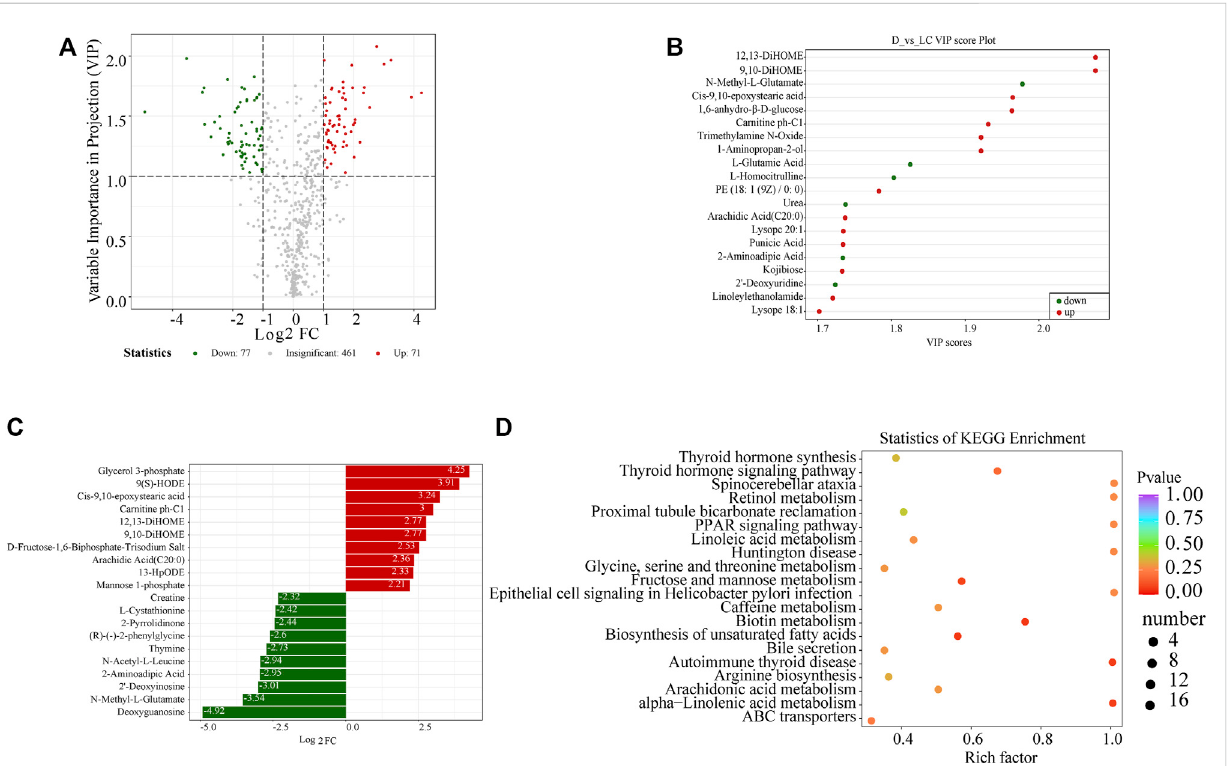
FIGURE 2 Signi fi cantDAMsinLuchuanandDuroc. (A) Volcanoplotofall609metabolitesdetected.Upregulatedmetaboliteswerede fi nedwithfoldchange ≥ 2 (red) while downregulated metabolites were with fold change ≤ 0.5 (green). In addition, a threshold of VIP > 1 was applied to distinguish DAMs from the unchangedones. (B) MetaboliteswiththehighestVIPscore. (C) Metaboliteswiththehighestlog2-transformedfoldchange. (D) Thetop20pathwayswith the lowest p -values. Rich factor is the ratio of the number of DAMs to all metabolites that were annotated to a pathway. The color of the dots represents level of enrichment, varying from red ( p = 0) to purple ( p = 1). The size of the dots indicates the number of DAMs annotated to a